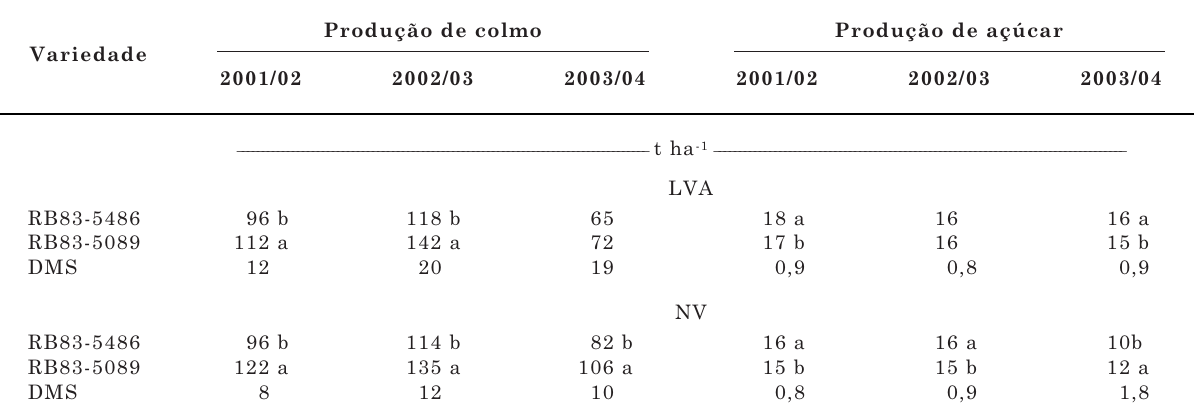
Quadro 4. Produção de colmos e de açúcar em três safras para os cultivares RB83-5089 e RB83-5486, plantados em dois solos